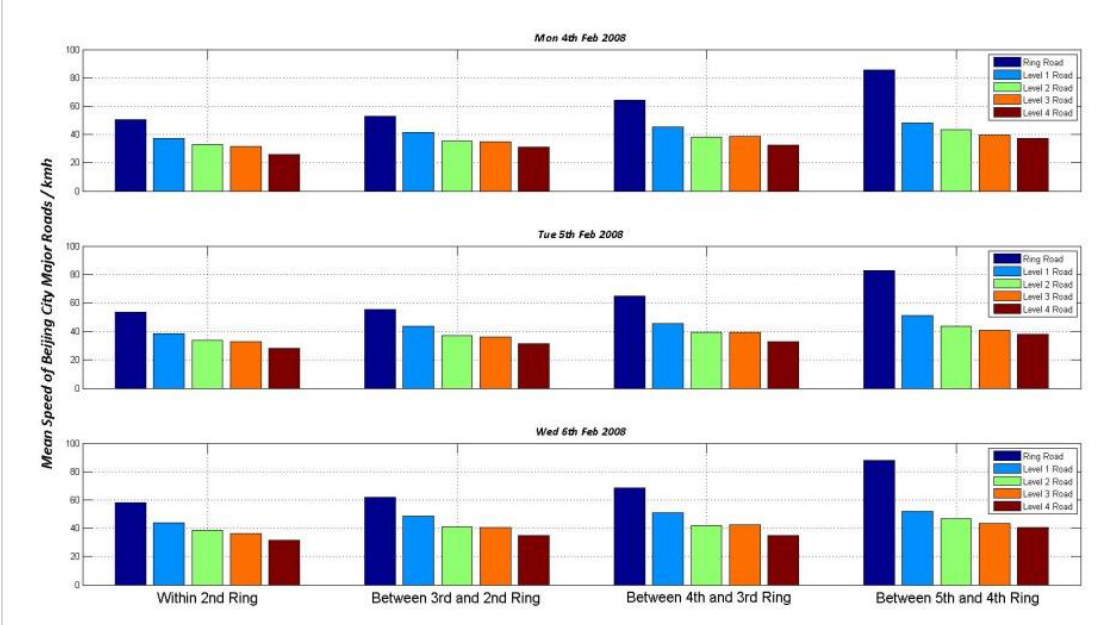
Figure 6. Average estimated link speed by type of link for the three days of testing The average link speed increases as we move outwards from the centre of Beijing.